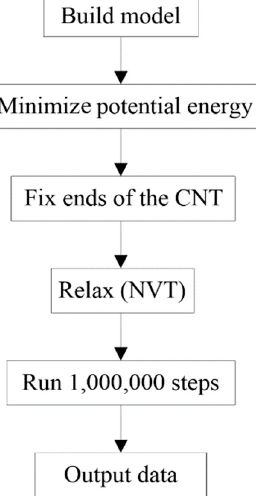
Table 7. The L–J potential parameters among carbon, hydrogen, and phosphorus atoms. Atom i Atom j σ ij (nm)